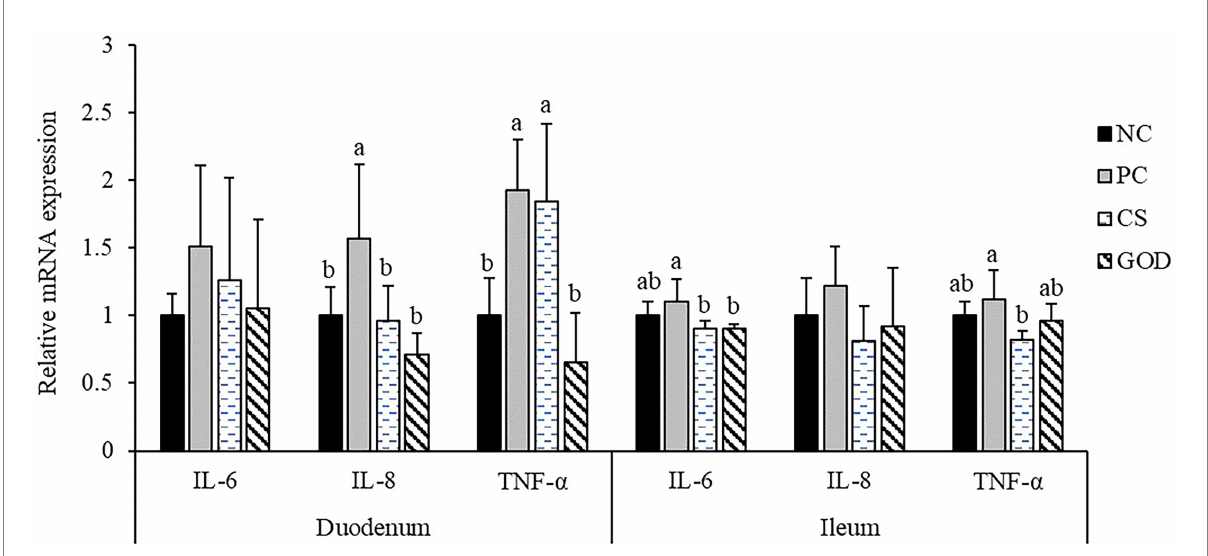
FIGURE 1 Effect of dietary treatments on the relative mRNA expression of intestinal inflammatory cytokines in piglets challenged by enterotoxigenic Escherichia coli (ETEC). a,b Values with different superscripts differ significantly ( p < 0.05). NC, negative control (piglets were free of the challenge); PC, positive control (piglets were challenged with ETEC on the 11th day of the experiment); CS, PC piglets supplemented with 40 g/t colistin sulfate; and GOD, PC piglets supplemented with 200 g/t glucose oxidase. Samples were analyzed on the 21st day of the